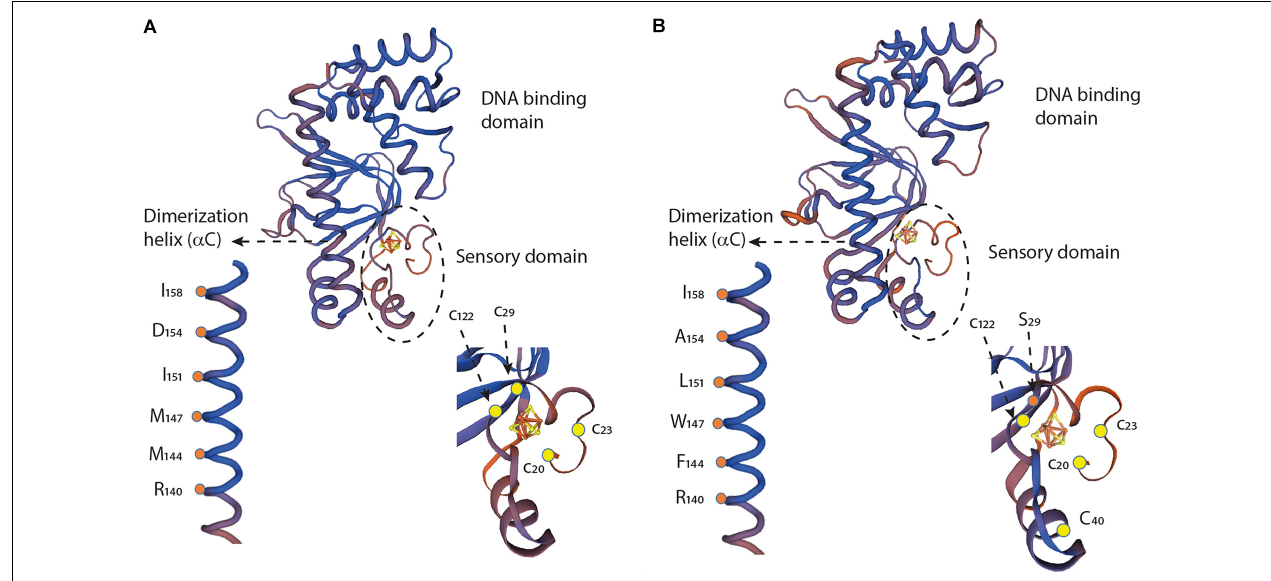
FIGURE 8 | Structural comparison and partial sequence comparison of (A) FNR EC and (B) FNR AF . Models of the three-dimensional structures of the respective monomers, showing the sensory domains, dimerization helices, and DNA binding domains, were created using the crystal structure of FNR AFi (PDB 5e44) as a template. Cartoons of the sensory domains and dimerization helices are enlarged to illustrate specific amino acid locations discussed in the text. [4Fe-4S] 2 + centers are illustrated with yellow and red Fe-S cage